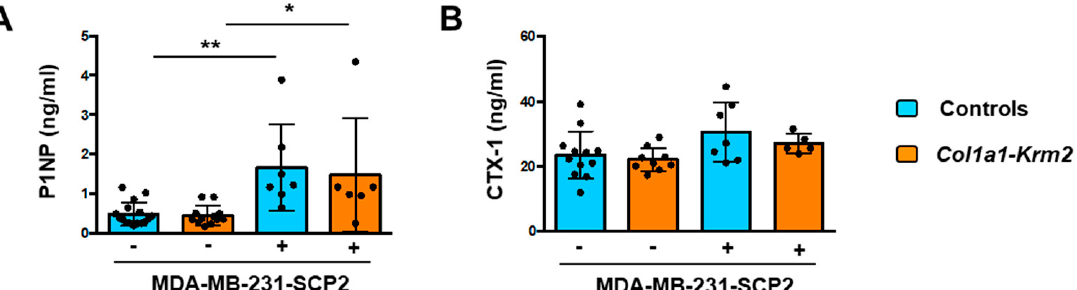
Figure 6. MDA-MB-231-SCP2 metastases cause a systemic activation of bone formation. ( A ) Serum concentrations of PINP in NSG mice (WT) and Col1a1-Krm2 -transgenic NSG mice ( Col1a1-Krm2 ) three weeks after injection of MDA-MB-231-SCP2 cells. ( B ) Serum concentrations of CTX-1 in the same mice. Data represent mean ± standard deviation ( n ≥ 5). Statistical significance was determined by one-way ANOVA; * p < 0.05, *** p < 0.0005.